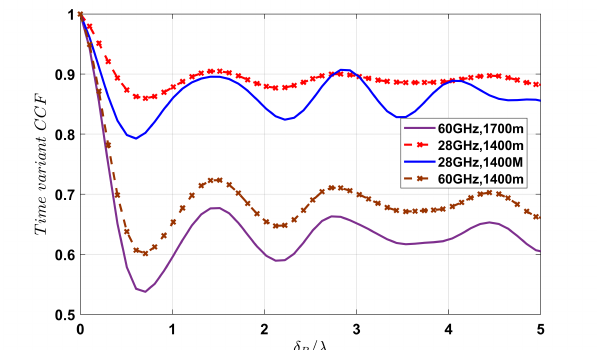
Figure 7. The absolute values of the time-variant space CCF at f c = 30 GHz, f c = 60 GHz and far distances of D s = 1400 m, D s = 1700 m with v R = 360 km/h.